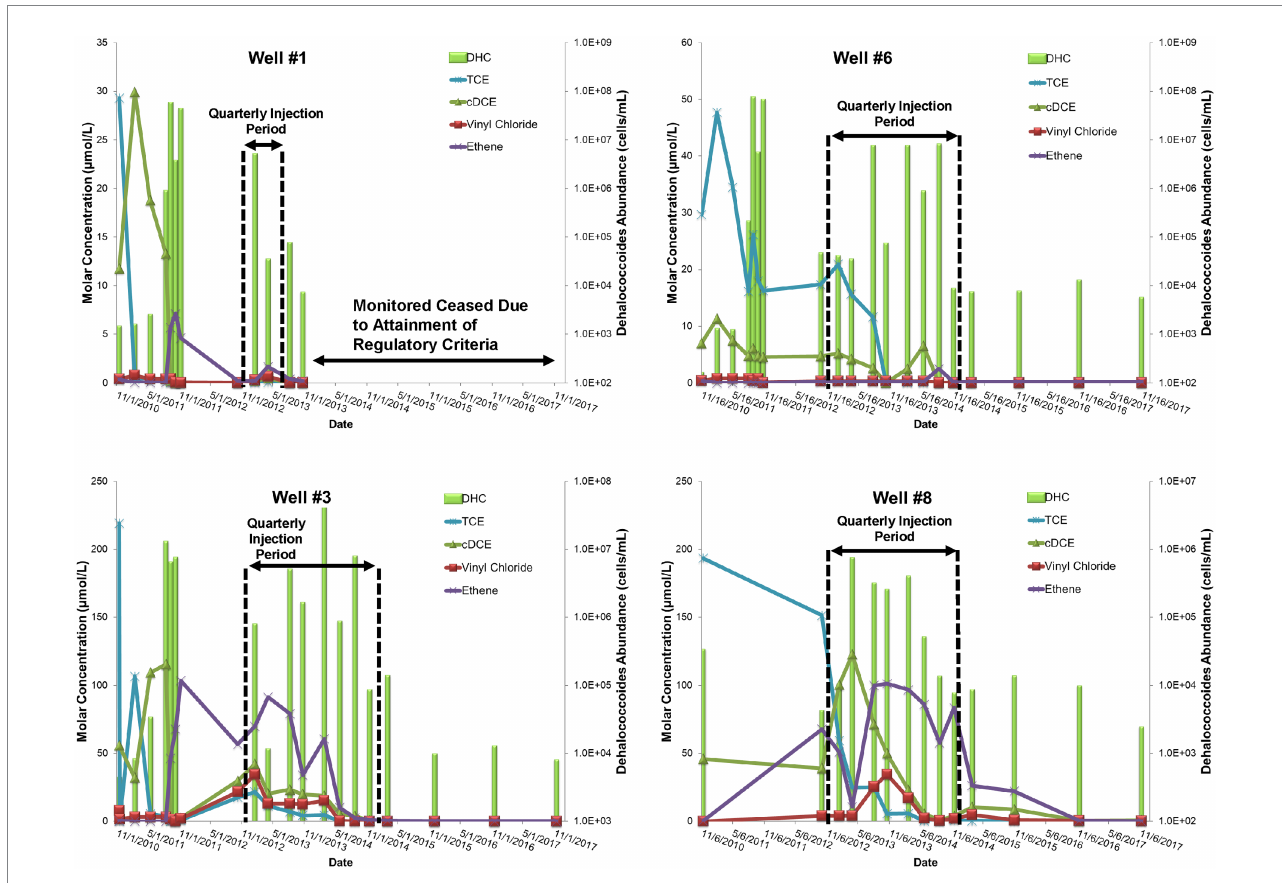
FIGURE 5 Site 1 full-scale implementation of enhanced bioremediation performance monitoring trends of TCE, cDCE, vinyl chloride, ethene, and DHC within the treatment